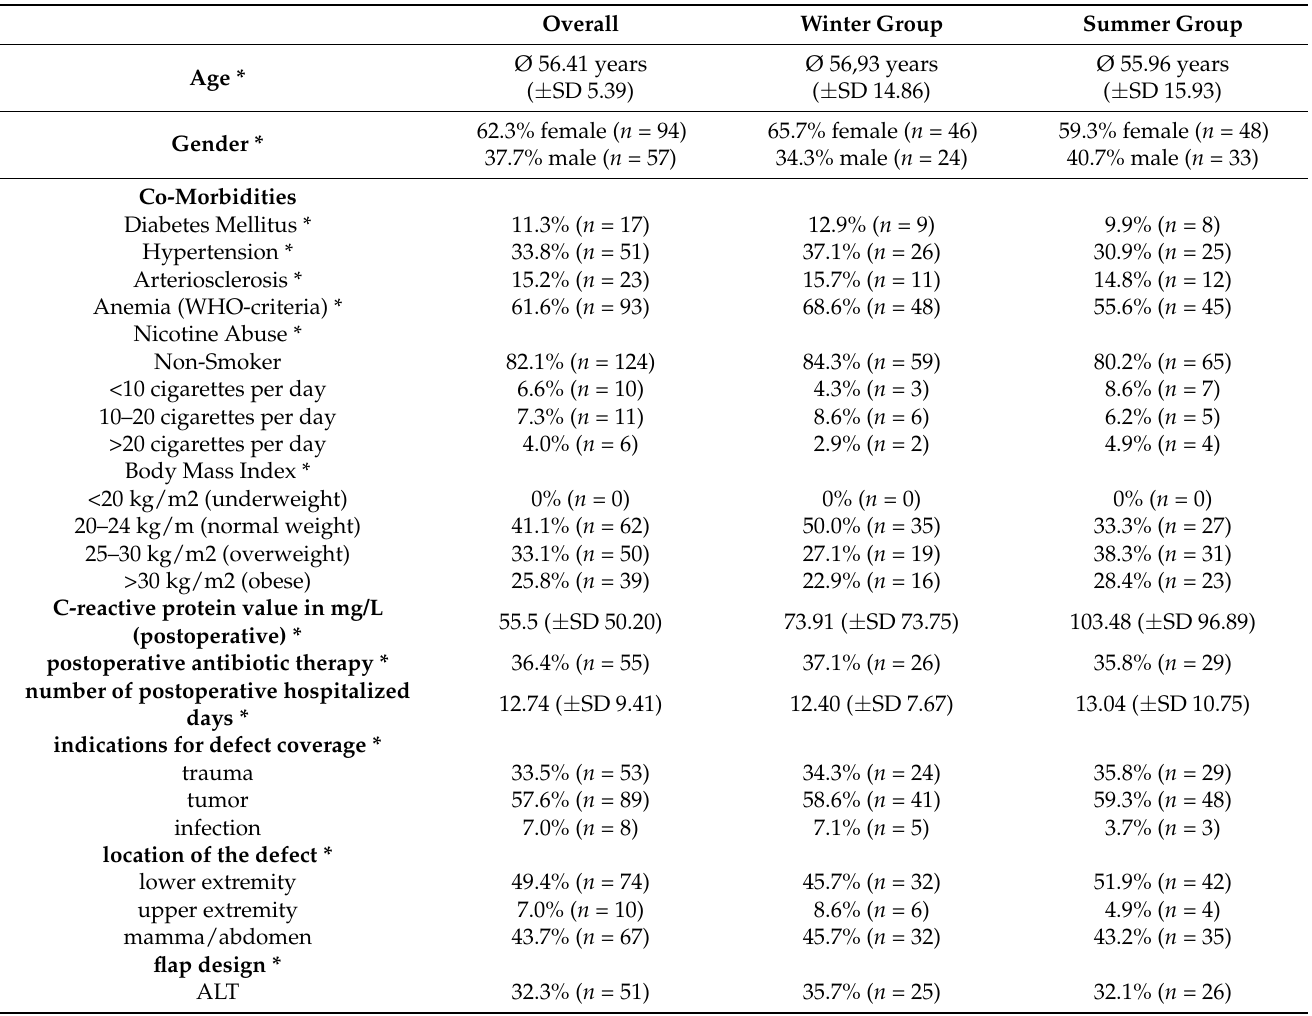
Table 1. Epidemiological data, * no statistically significances between winter and summer